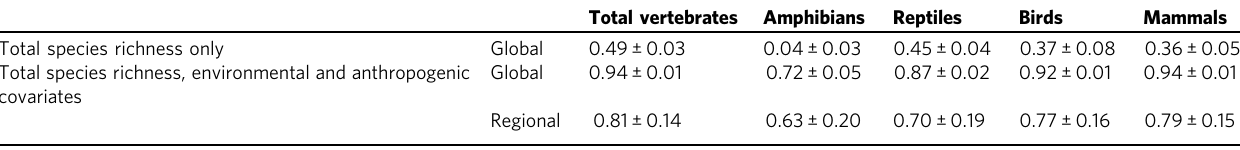
Table 1 Performance (R 2 ) of models of threatened species richness.